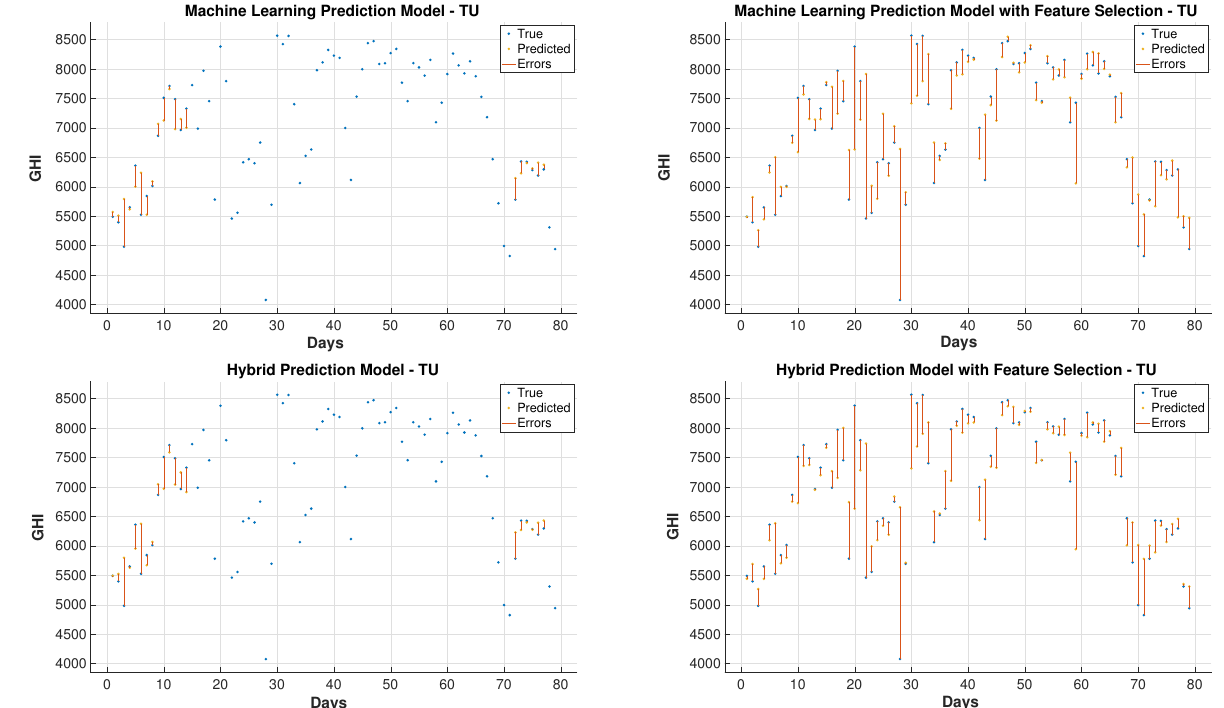
Figure 21. Prediction models for TU with the dust storm